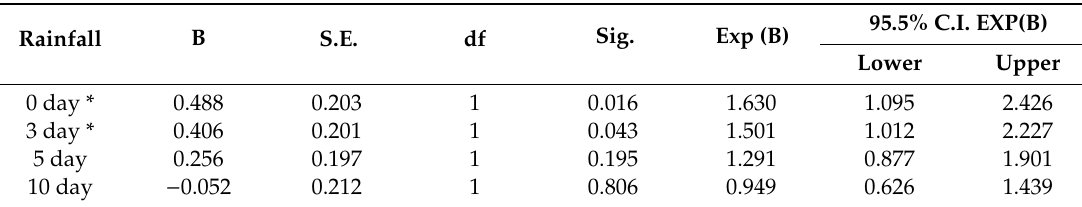
Table 4. Univariate logistic regression analysis of the rainfall in di ff erent days before the occurrence of tilapia streptococcosis.